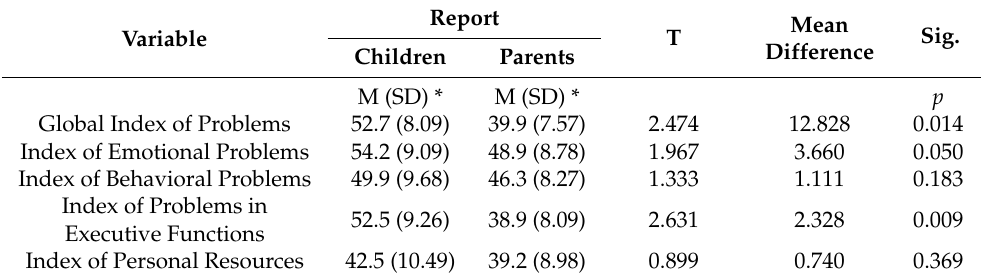
Table 2. T-test of Global Indexes reported by children and their parents.